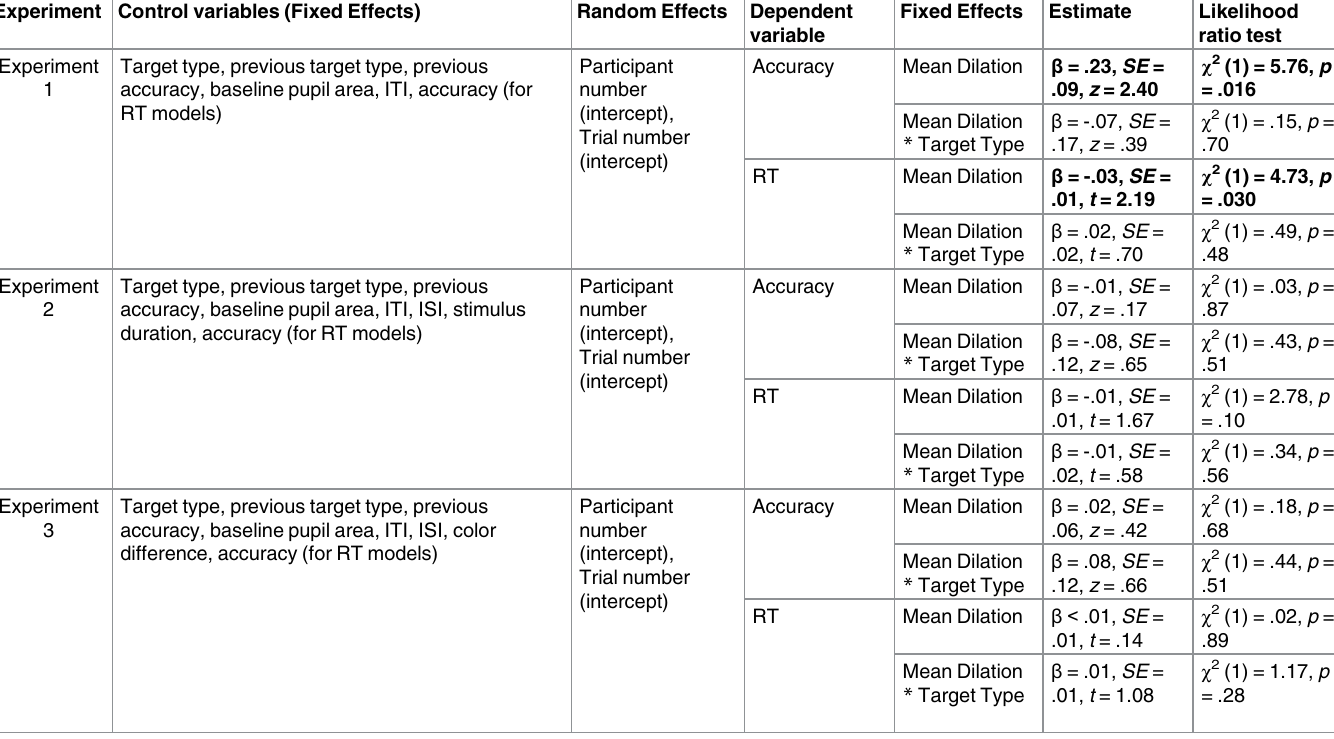
Table 1. Linear mixed effects models and results for Experiments 1–3 (significant results in